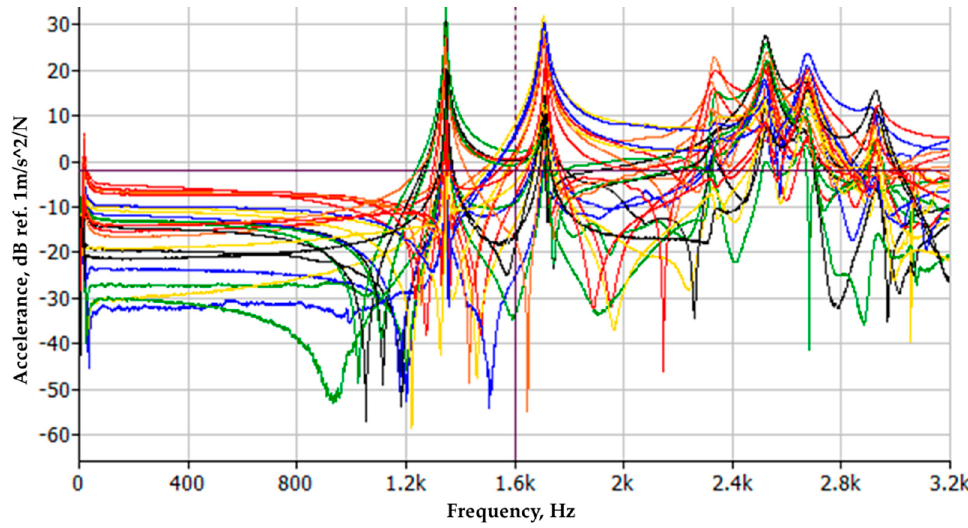
Figure 4. Frequency response functions (FRFs) of the housing.